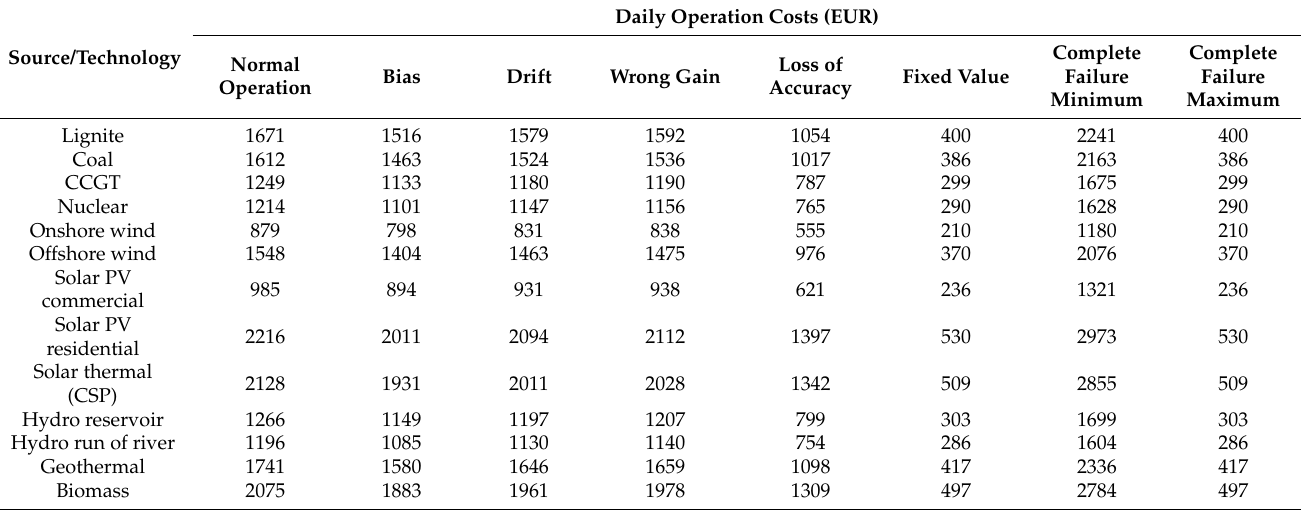
Table 4. Source depending sum of AE and PE energy costs computed for normal and fault affected op-